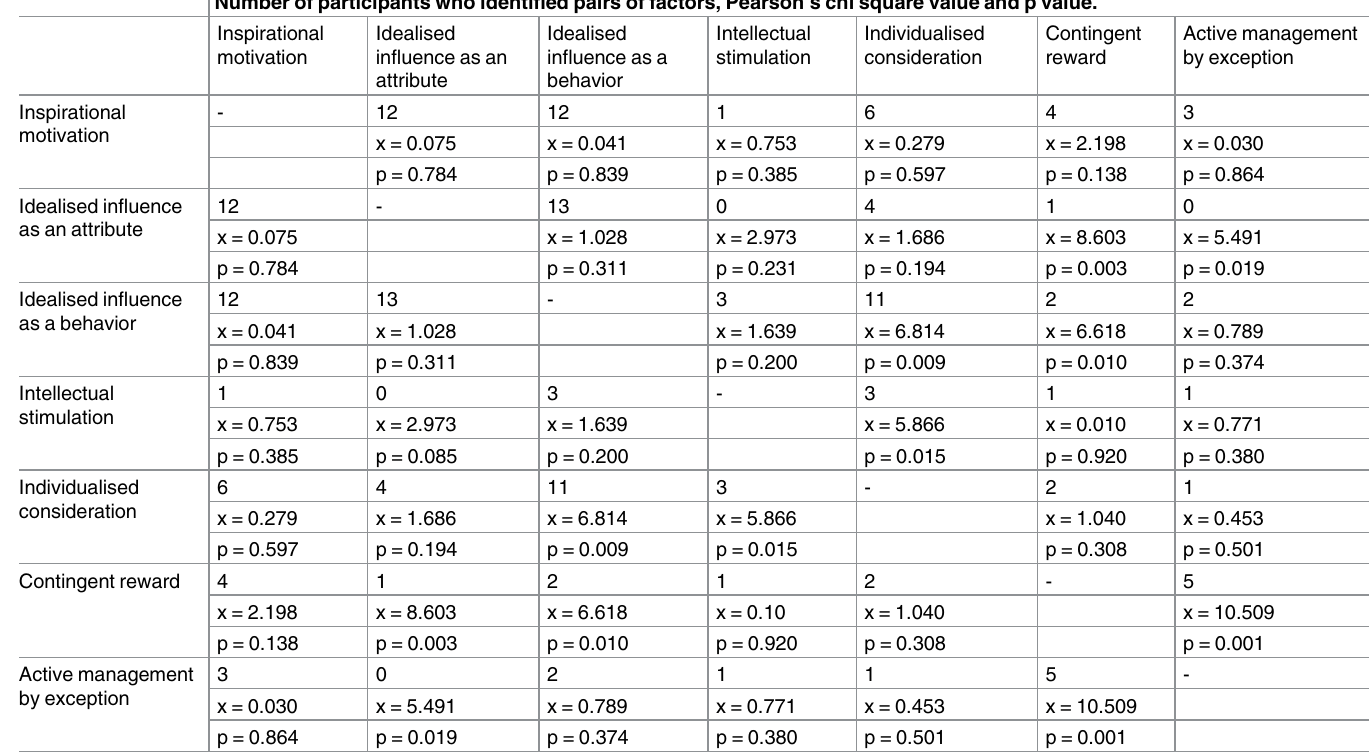
Table 3. Pairs of factors identified by participants when defining leadership. Number of participants who identified pairs of factors, Pearson’s chi square value and p